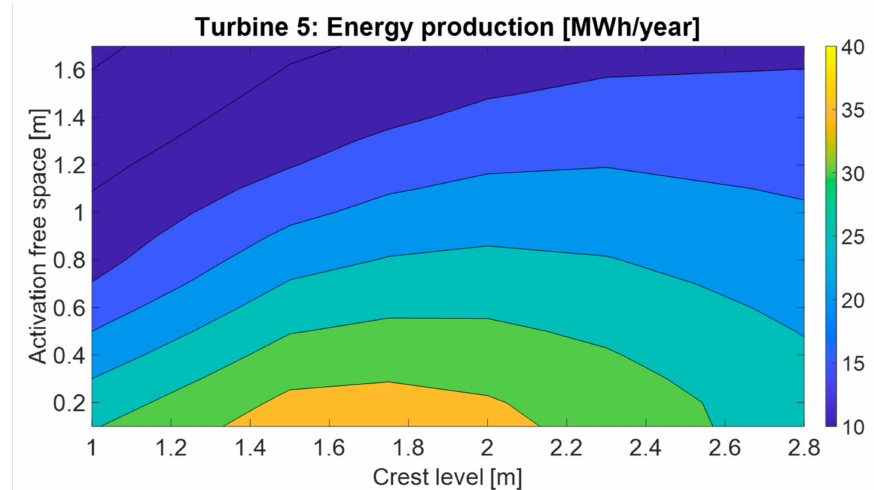
Figure 11. Energy produced by Turbine 5 as a function of the activation free space f a and the crest level h cr .